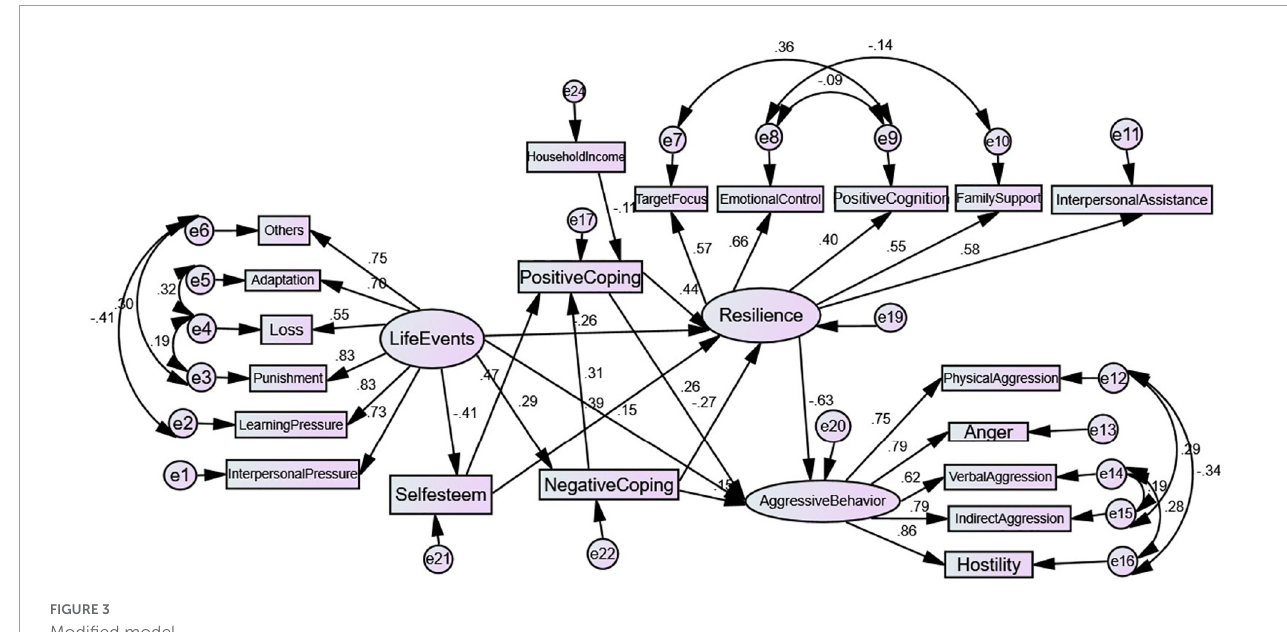
FIGURE3 Modified model.